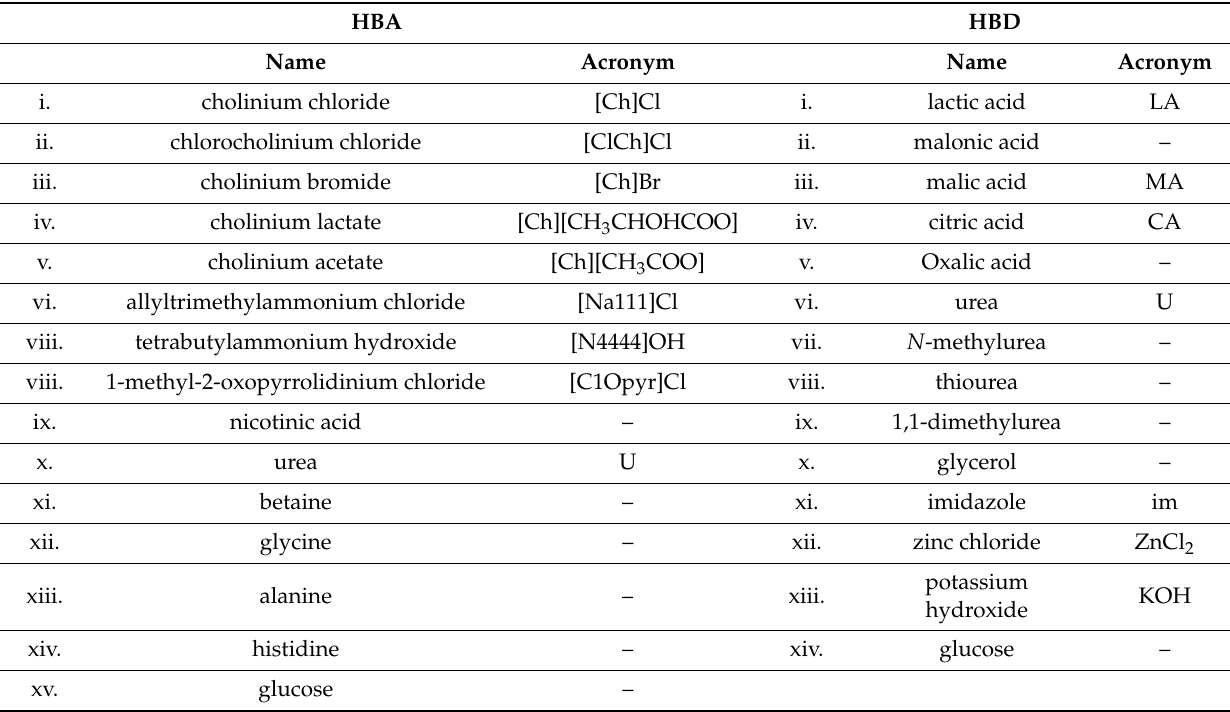
Table 3. Name and respective acronym of the hydrogen bond acceptor (HBA)–hydrogen bond donor (HBD) combinations in deep eutectic solvents